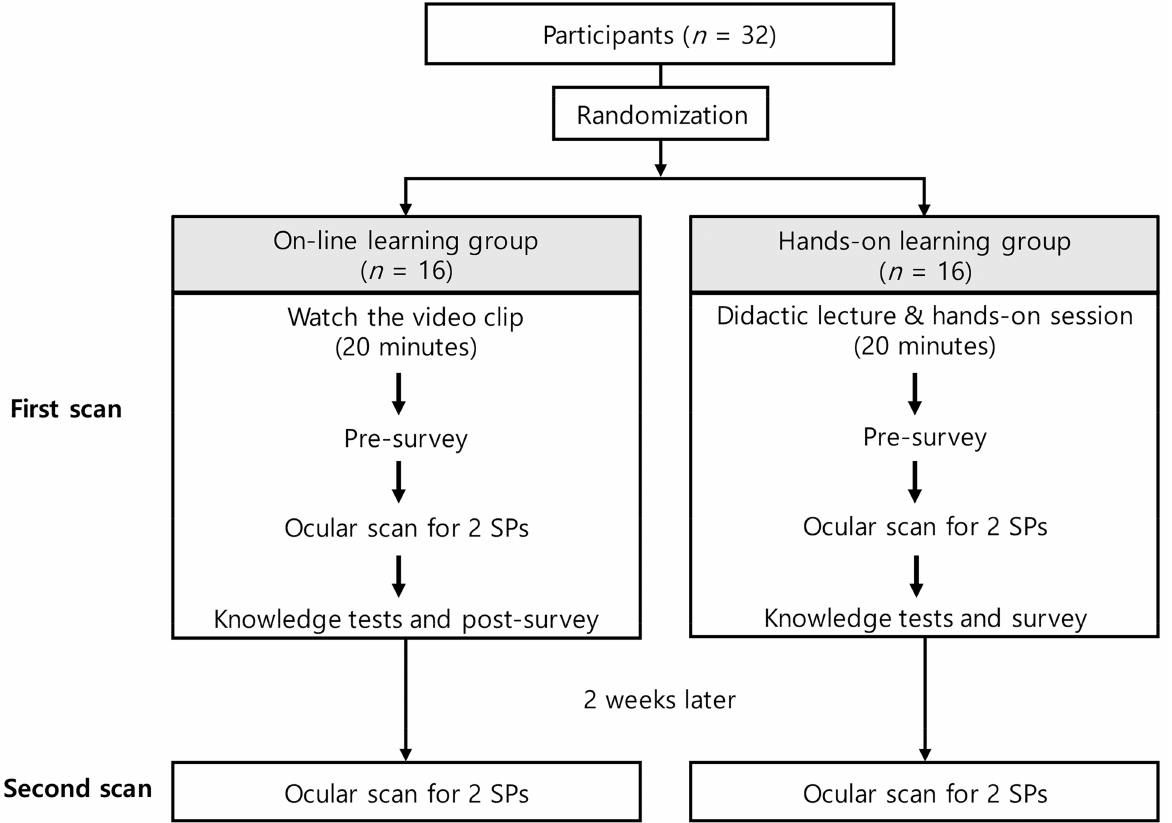
Figure 1. The study flow. Abbreviation: SP, standardized